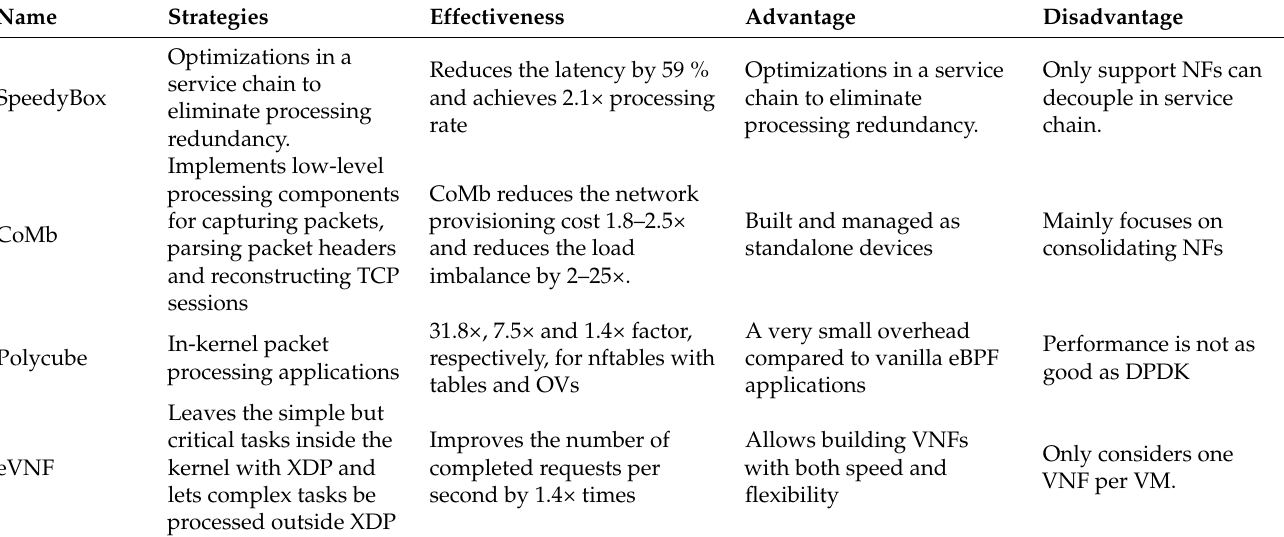
Table 3. The acceleration solutions in EMS by